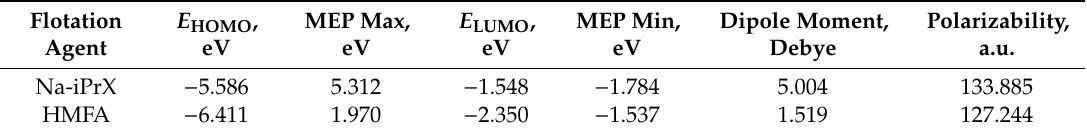
Figure 4. The HOMO ( left ) and LUMO ( right ) of HMFA mapped on isovalue of 0.04 a.u. The HOMO, LUMO energies, dipole moments, and polarizability of Na-iPrX and HMFA are listed in Table 8. Table 8. Overview of HOMO and LUMO energies, MEP extrema, dipole moments, and polarizabilities for two flotation agents.